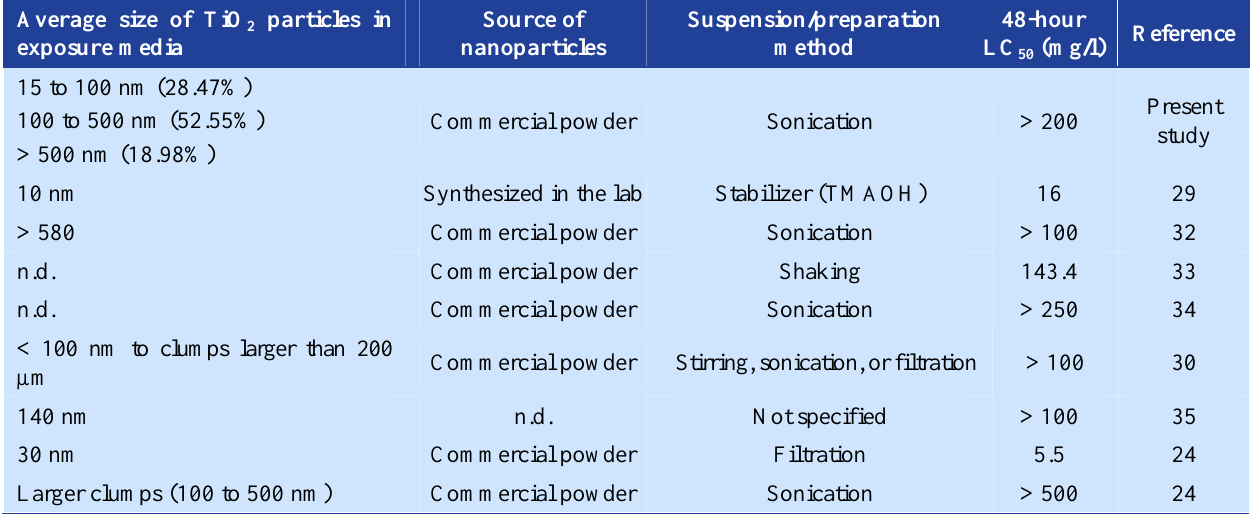
Table 1. A summary of the results of several studies on acute toxicity of titanium dioxide nanoparticles (nTiO ) in Daphnia magna 2